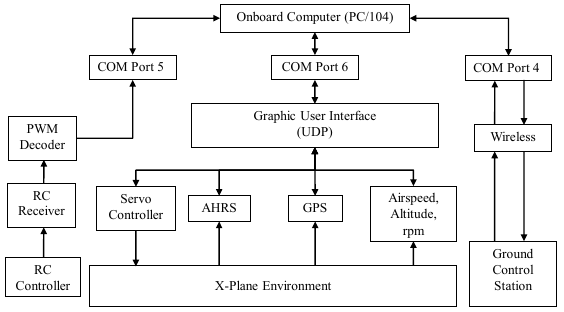
Figure 11. Architecture of Spoonbill HIL system. HIL, hard ‐ in ‐ the ‐ loop; COM, communication port; PWM, Pulse Width Modulation; RC, radio control; AHRS, attitude and heading reference system; GPS, Global Positioning System; UDP, User Datagram Protocol.